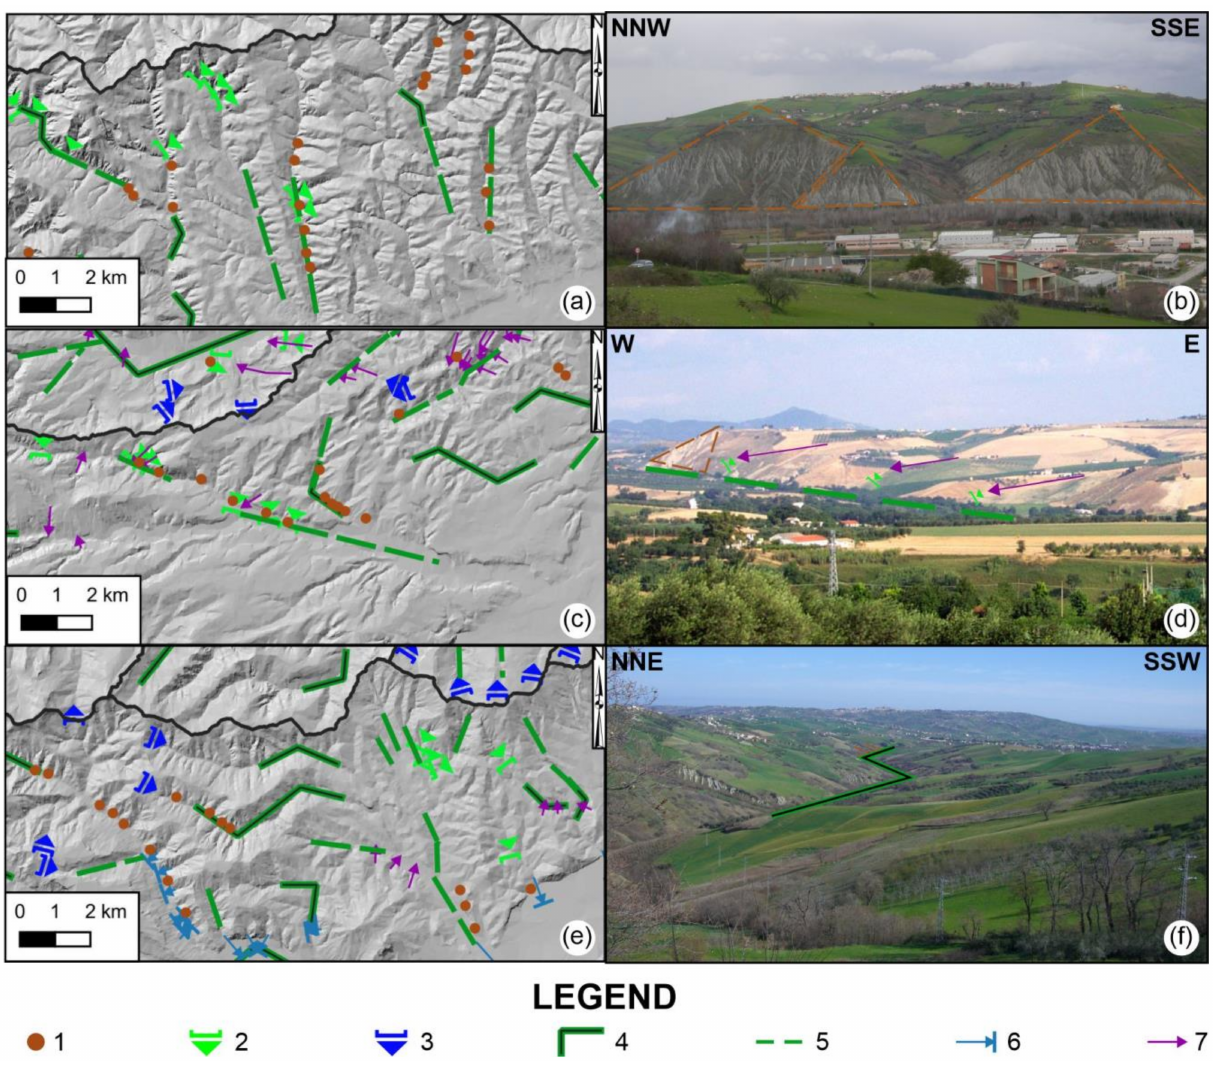
Figure 7. Morphological field evidence of tectonics over the study area (for the location of the frames, see Figure S1 in Supplementary material). Legend: (1) triangular facets (point of identification), (2) hanging valleys, (3) beheaded valleys, (4) river bends, (5) rectilinear fluvial segments, (6) 90 ◦ confluences, and (7) counterflows confluences. ( a ) Frame in the left valley side of the middle Tronto River valley; ( b ) triangular facets along a secondary stream of the Tronto River; ( c ) frame in the left valley side of the middle Pescara River valley; ( d ) panoramic view of a stream characterized by rectilinear fluvial segments, counterflow confluences, hanging valleys, and triangular facets; ( e ) frame in the left valley side of the middle Sangro River valley; ( f ) panoramic view of a stream characterized by river bends and triangular facets. Note: a main map of these morphological field evidence is provided as Supplementary material (Figure